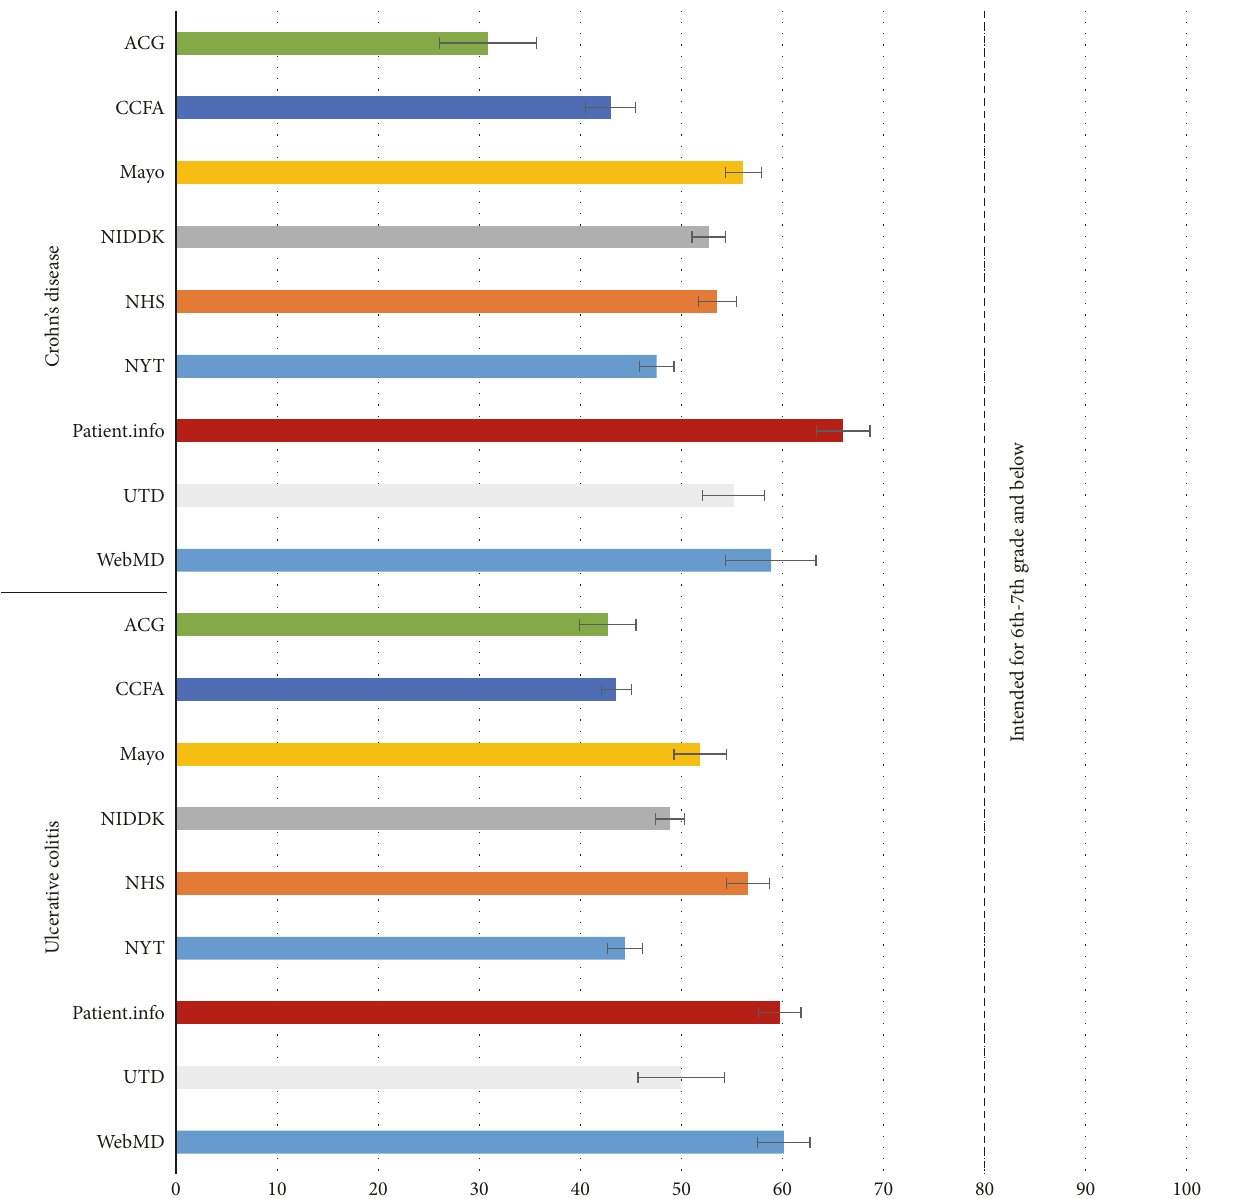
Figure 5: Assessment of text using FRE readability test per website, calculated by the mean FRE scores of each subsection within each website. This figure depicts a bar graph with elevated reading grade level comprehension required for different websites analyzed. A score from 90 to 100 is intended for 11-year-old students and from 60 to 70 for 13–15-year-olds and a score from 0 to 30 is best understood by university graduates. Vertical axis at 𝑥 = 80 approximates to 6th-grade level of comprehension. FRE: Flesch Reading Ease; ACG: American College of Gastroenterology; CCFA: Crohn’s and Colitis Foundation of America; Mayo: Mayo Clinic; NIDDK: National Institute of Diabetes and Digestive and Kidney Diseases; UTD: UpToDate, Beyond the Basics; NHS: National Health Service; NYT: New York Times Health